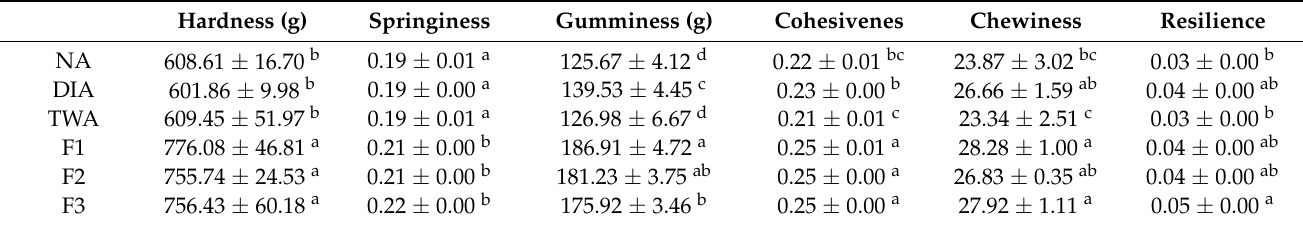
Table 2. Textural profiles of the steamed cold noodles that were not colored (NA), colored with deionized water-dissolved BRA (DIA), colored with tap water-dissolved BRA (TWA), and colored with tap water-dissolved BRA containing the three optimized chelator formulations (F1–F3). Springiness Gumminess (g) Cohesivenes Chewiness